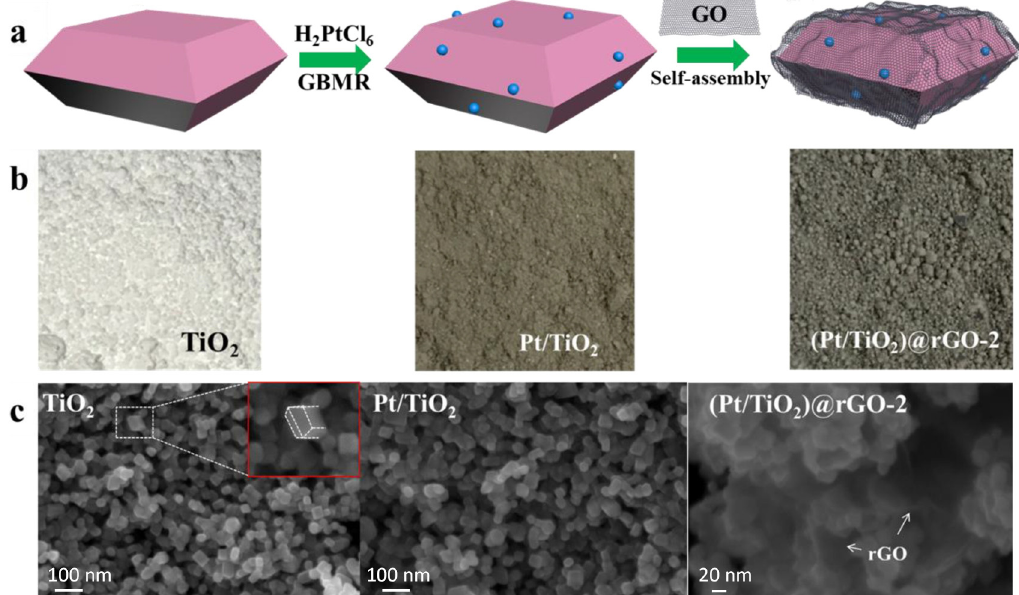
Figure 1. Preparation procedure and photographs of ( Pt/TiO 2 )@rGO photocatalysts: ( a ) the schematic graph for the two-step synthesis of supported Pt NPs and wrapping rGO shells on the surface of TiO 2 nanocrystals; ( b ) the digital photograph and ( c ) SEM images of TiO 2 , Pt/TiO 2 and (Pt/TiO 2 )@rGO. Reprinted with permission from [38] after slight modification. Copyright 2018 Elsevier.